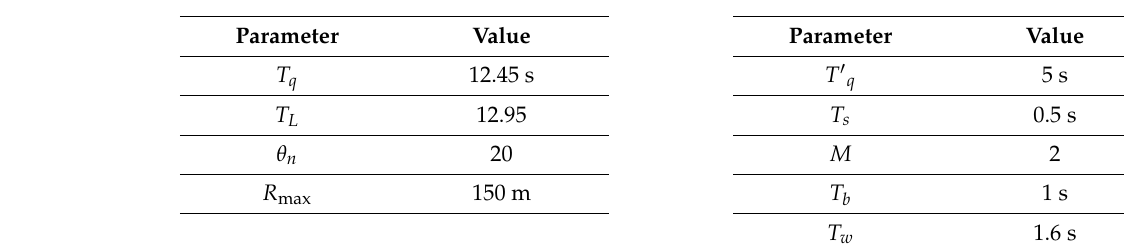
Table 3. Parameters used by the existing method (left) and the proposed method (left and right).